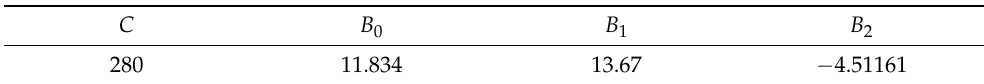
Table 6. Larson–Miller parameters of P91.